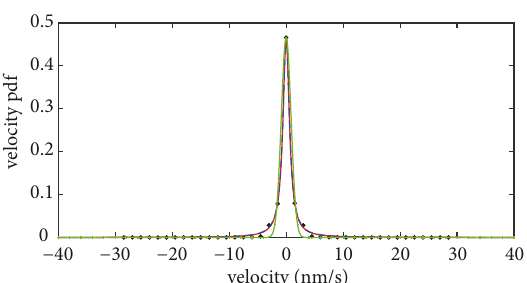
Figure 3: Velocity PDF: the solid line (red) represents the Cauchy-Lorentz distribution, the dash line (blue) is the truncated Cauchy-Lorentz distribution, the “+” line (green) is the Gaussian distribution, and the black dots are the experimental data, when I=0.01 (tunneling current) V=0.01 (bias voltage).